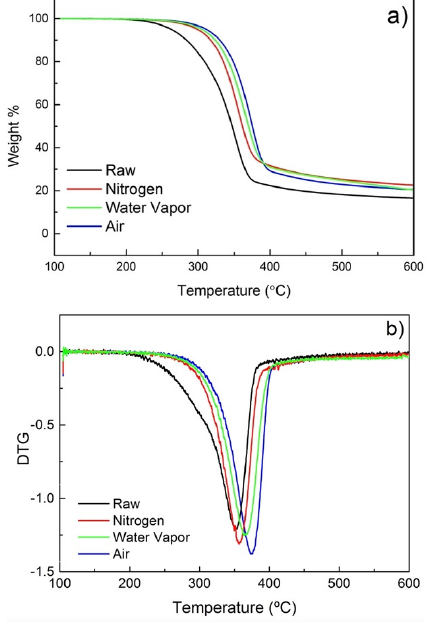
Figure 6. ( a ) TGA and ( b ) DTG for poplar treated under varying atmospheres.